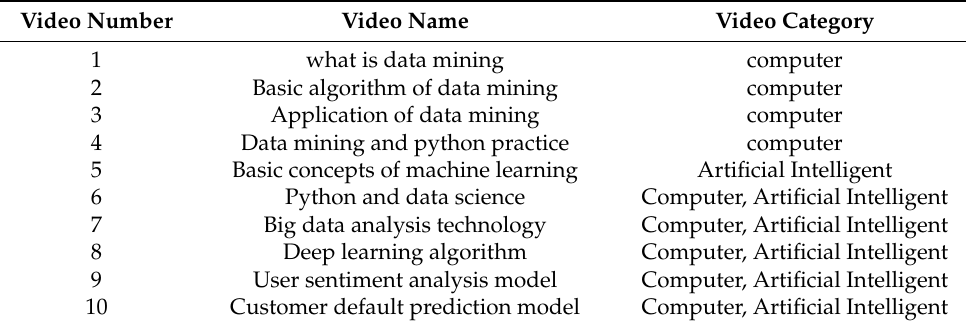
Table 7. Video learning